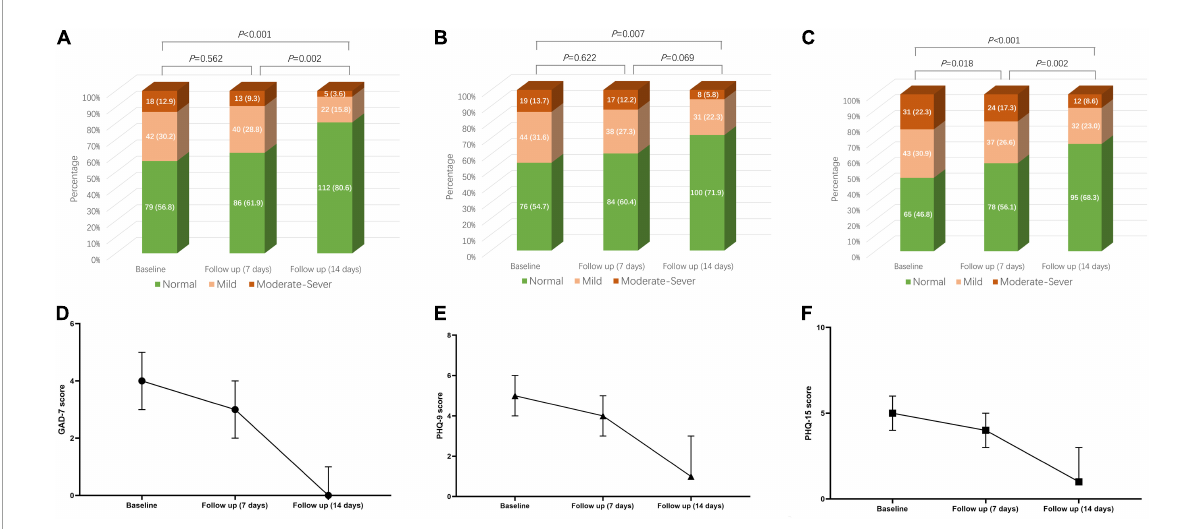
FIGURE2 Change trend of GAD-7 score, PHQ-9 score, and PHQ-15 score over time and the change of anxiety, depression, and somatic symptom disorder severity over time based on the above scores. (A) Anxiety composition based on GAD-7 score at baseline, day 7 and day 14. (B) Depression composition based on PHQ-9 score at baseline, day 7 and day 14. (C) Somatic symptom disorder composition based on PHQ-9 score at baseline, day 7 and day 14. (D) Change trend of GAD-7 score over time. (E) Change trend of PHQ-9 score over time. (F) Change trend of PHQ-15 score over time. GAD-7, Generalized Anxiety Disorder 7-Item Scale; PHQ-9, Patient Health Questionnaire-9; PHQ-15, Patient Health Questionnaire-15.